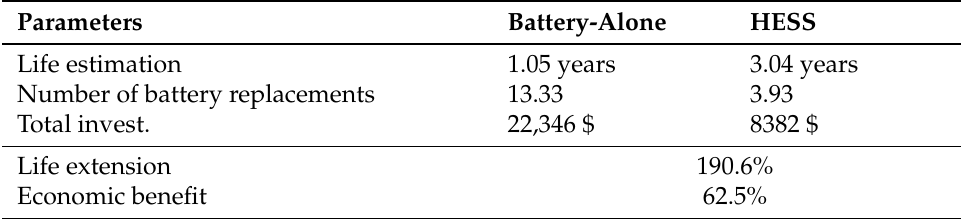
Table 7. Results of scenario 2.